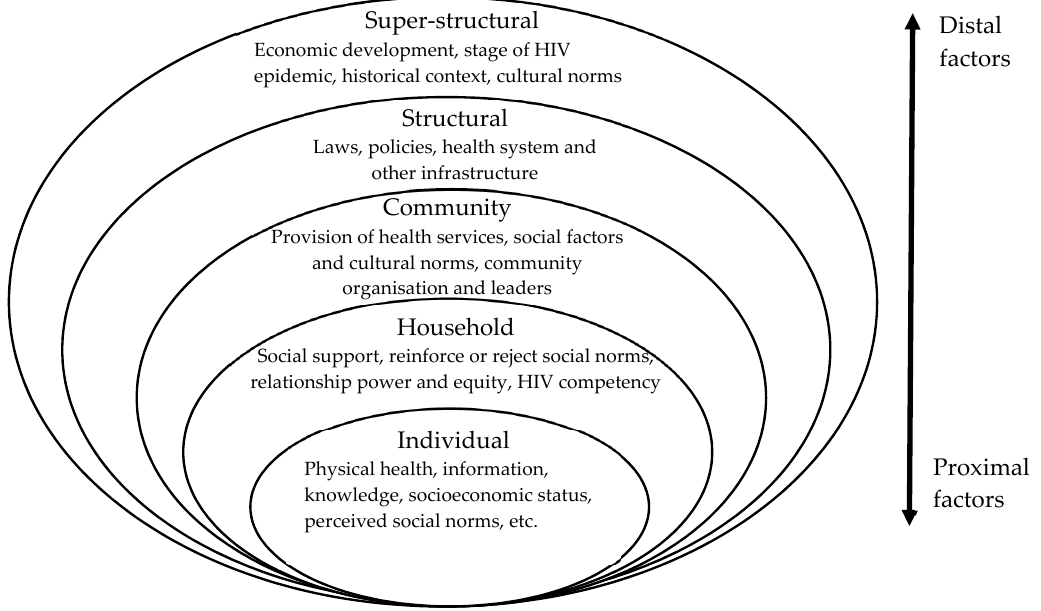
Figure 1. Adapted socio-ecological model of social and structural determinants of HIV transmission, vulnerability and antiretroviral therapy (ART) adherence, drawing together the frameworks proposed by Sweat and Denison (1995), Baral et al. (2013), and Wouters (2012) [24,28,31].